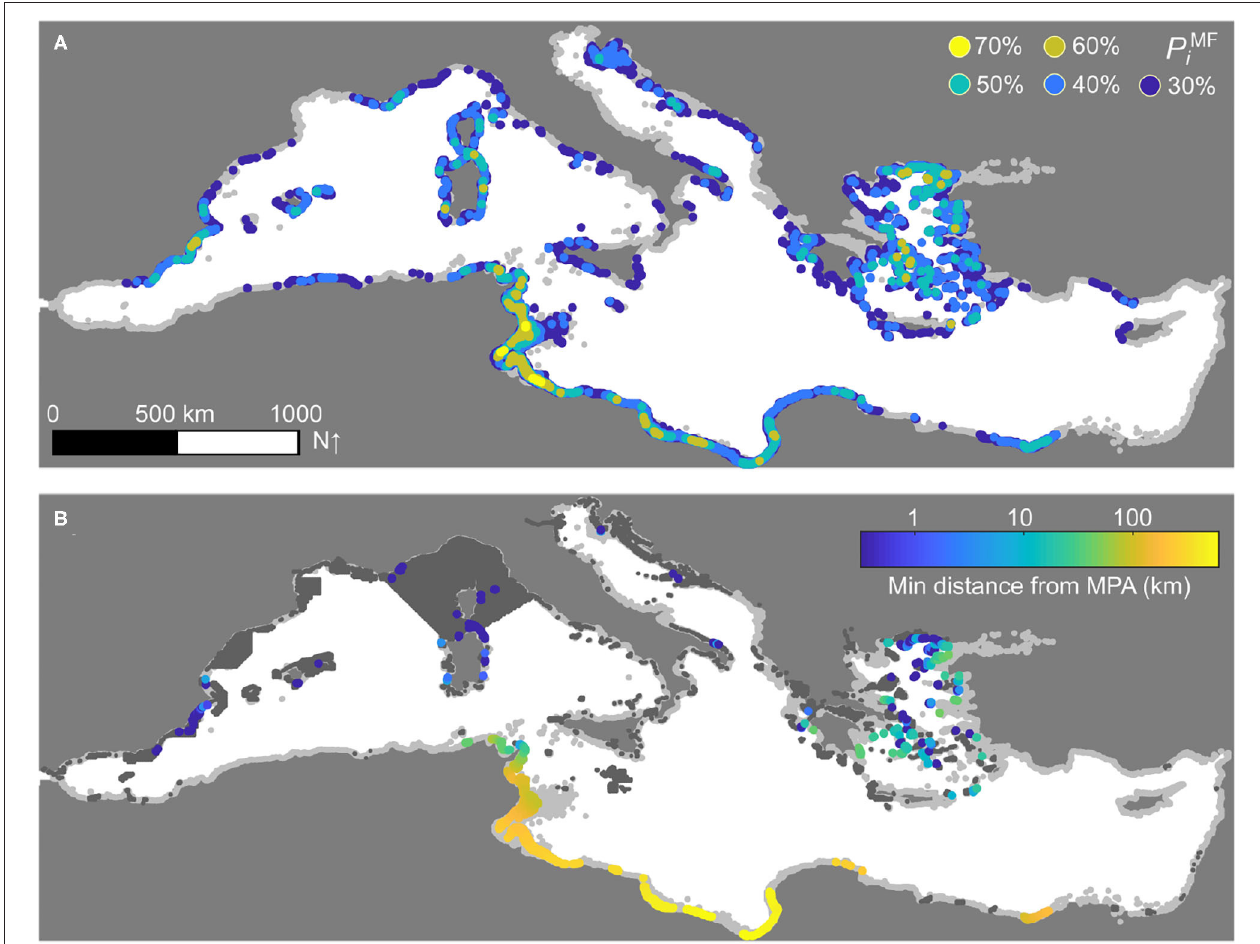
FIGURE 6 | Multi-functional hotspots and protection gaps for P. oceanica . (A) Sectors that are above the k -th percentile in the across-sector distribution of the multi-functional percentile score P MF i ( k ∈ { 30,40,50,60,70 } ). Sectors for which P MF i < 30 % are shown in light gray. (B) Distance (log 10 scale) between the centroids of marine sectors with P MF i ≥ 50 % and the closest marine protected area. Protected sites have been extracted from the MPAtlas database ( Marine Conservation Institute, 2019 ) and are shown in dark gray, while marine sectors with P MF i < 50 % are in light gray. Results refer to the simulation of Figure 2 .